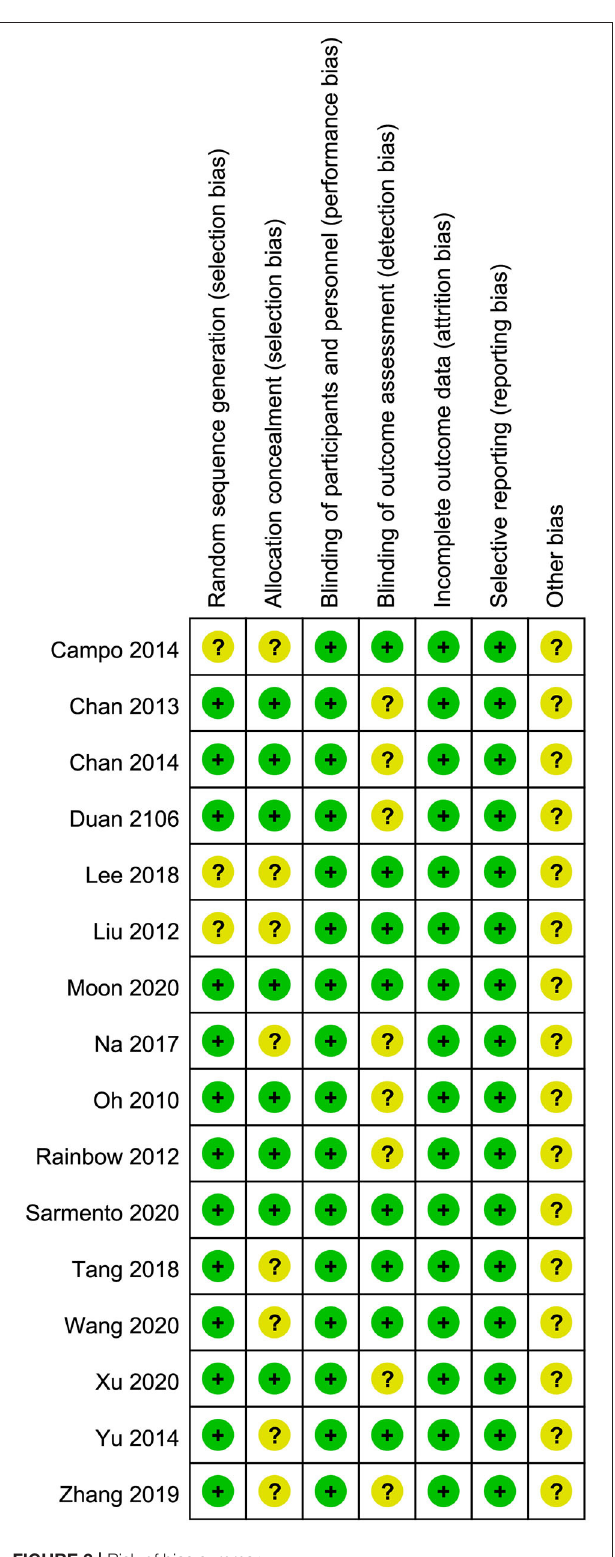
FIGURE 2 | Risk of bias